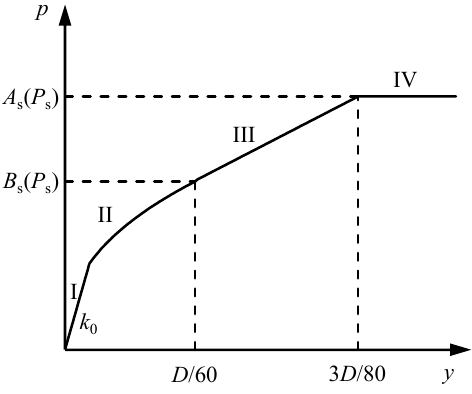
Figure 1. The p-y curve in sand proposed by Reese et al. Figure 1. The p ‒ y curve in sand proposed by Reese et al. [18].